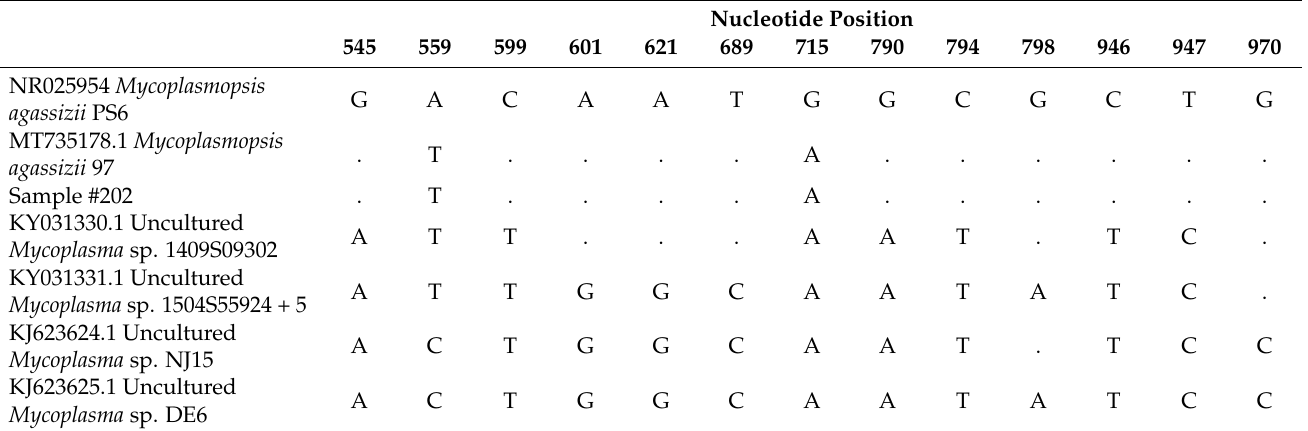
Table 4. Nucleotide variations in the 16S rRNA sequences representative of strains and samples. Sample #202 is representative of all sequences obtained in this study. Sequences are aligned with reference to the type strain PS6 (ID NR025954). Dots (.) indicate sequence